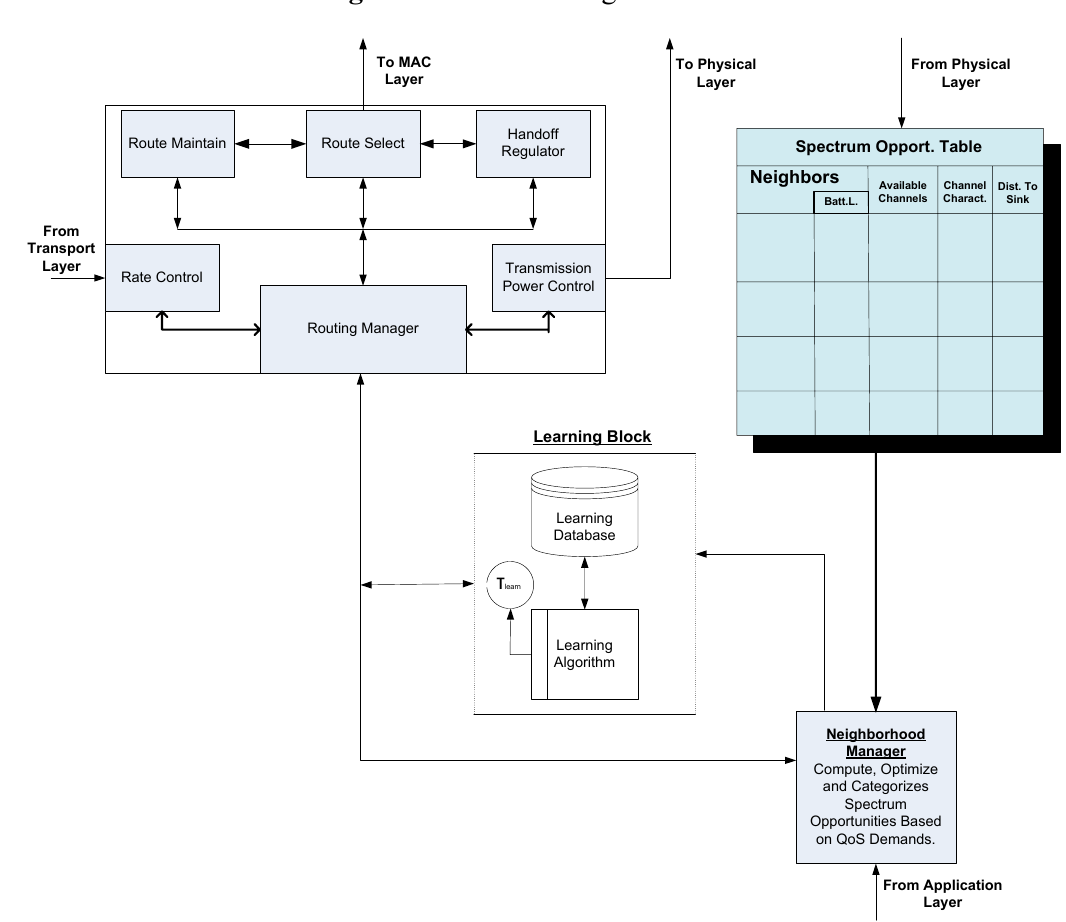
Figure 8. CRSN routing